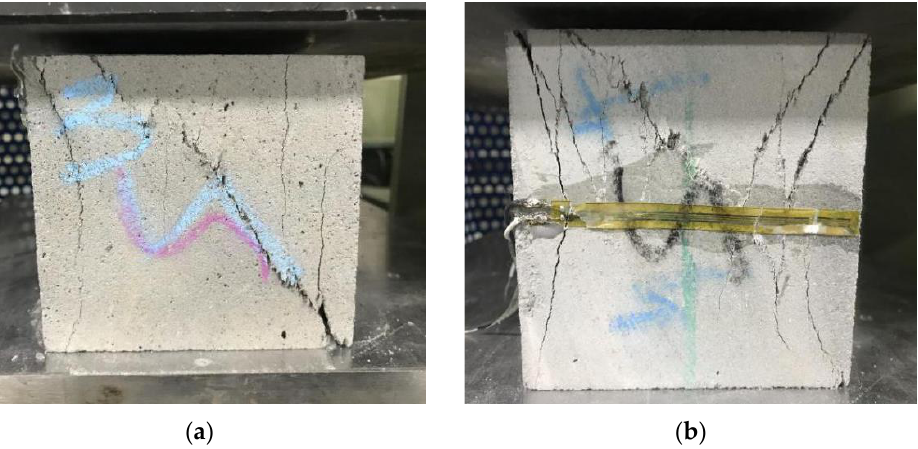
Figure 14. The printed cube sample cracks of ( a ) C and ( b ) reverse plane on the X-direction com- pression.